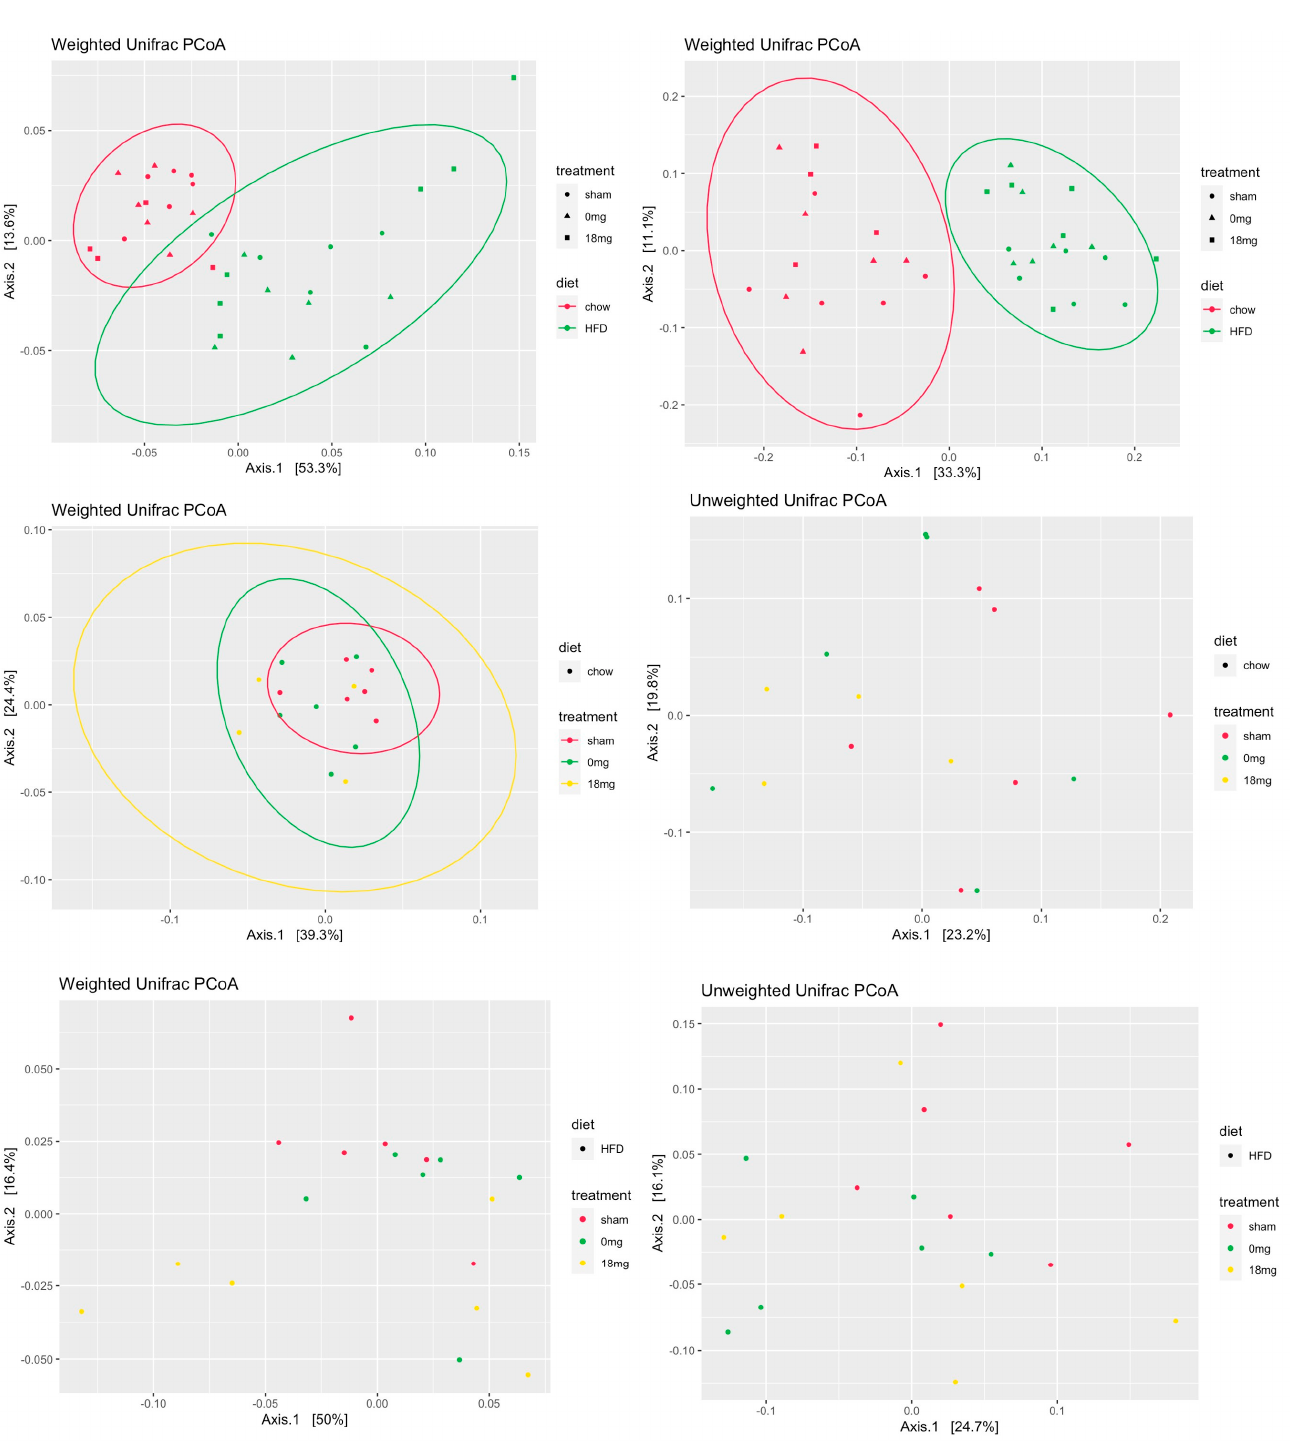
Figure 2. Beta diversity. HFD: high-fat diet; sham: exposed to ambient air; 18 mg: exposed to nicotine-containing e-vapour; 0 mg: exposed to nicotine-free e-vapour.